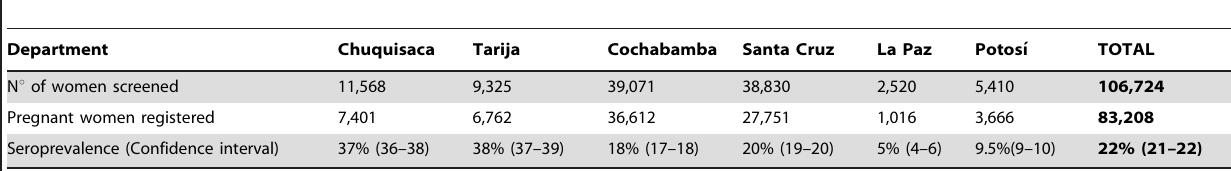
Table 2. Pregnant women screened compared with pregnant women registered in health facilities and seroprevalence